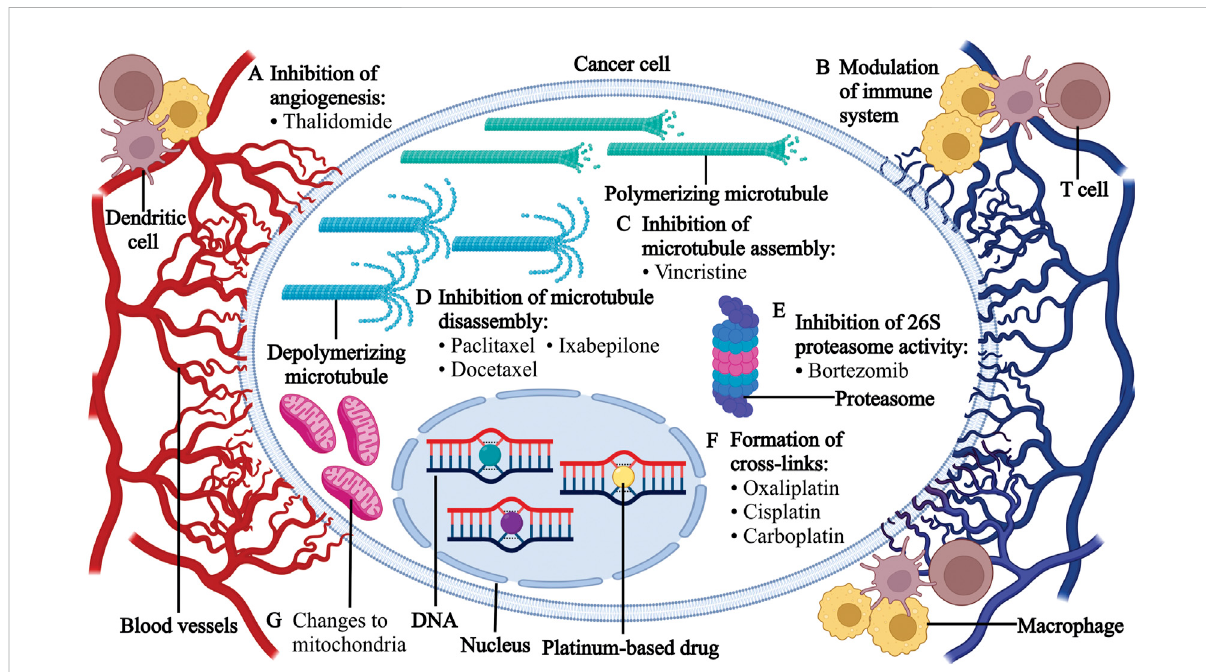
FIGURE 1 Modeofactionofchemotherapeuticagentsincancercells. (A) Thalidomideinhibitsangiogenesis,preventstheproductionofinterleukin-6and activates apoptotic pathways via caspase 8-mediated cell death. (B) Chemotherapy affects the tumor immune microenvironment. (C) Vincristine bindstothe β -tubulinsubunitofmicrotubuleintheSphaseofthecellcycle,whichleadstotheinhibitionofmicrotubuleassembly. Thedisruptionof mitotic spindle formation results in the mitotic arrest of cancer cells at metaphase and subsequent cell death. (D) Paclitaxel, docetaxel and ixabepilonebindto the β -tubulin subunitof microtubule and inhibitmicrotubuledisassembly,which causesG2/M cell cyclearrest and cell death. (E) Bortezomib reversibly inhibits the 26S proteasome, which disrupts proteasome-mediated proteolysis. This disruption causes the accumulation of ubiquitinated proteins and subsequent cell death. (F) Oxaliplatin, cisplatin and carboplatin bind to DNA to form cross-links that prevent DNA replication and transcription, leading to cell cycle arrest and apoptosis. (G) Vincristine, paclitaxel and docetaxel alter the mitochondrial electron transport chain while cisplatin results in the increased production of reactive oxygen